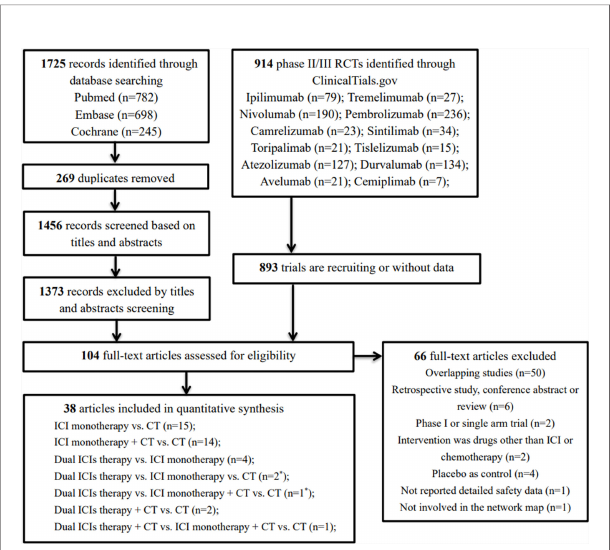
FIGURE 1 | Flow diagram for the selection of eligible studies. ICI, immune checkpoint inhibitor; CT, chemotherapy; n, number; *, one study involved two groups, dual ICIs therapy vs. ICI monotherapy vs. CT (group A) and dual ICIs therapy vs. ICI monotherapy + CT vs. CT (group